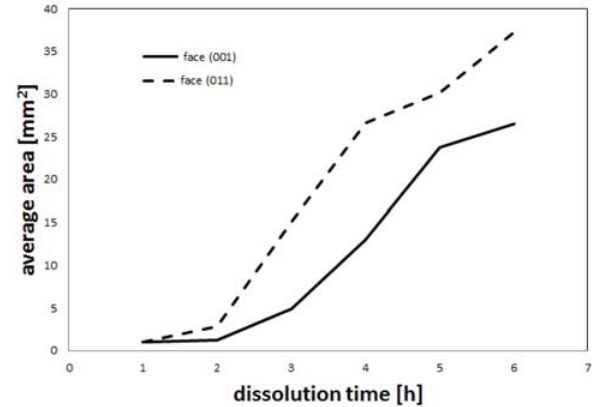
Figure 9: Area of the formed voids as a function of the dissolution time. Average of the measured projected area (2D) of 10 individual voids is plotted for each